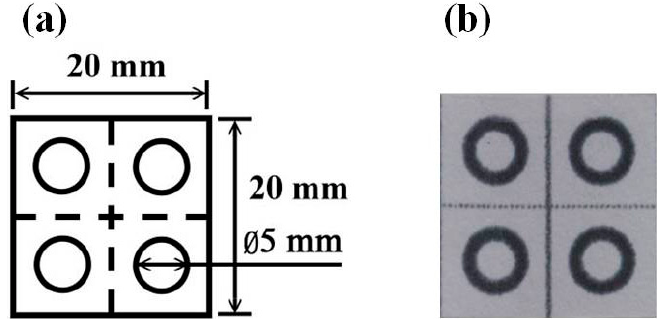
Figure 1. ( a ) Schematic illustration of paper-based analytical device; ( b ) Photograph of paper-based analytical device.